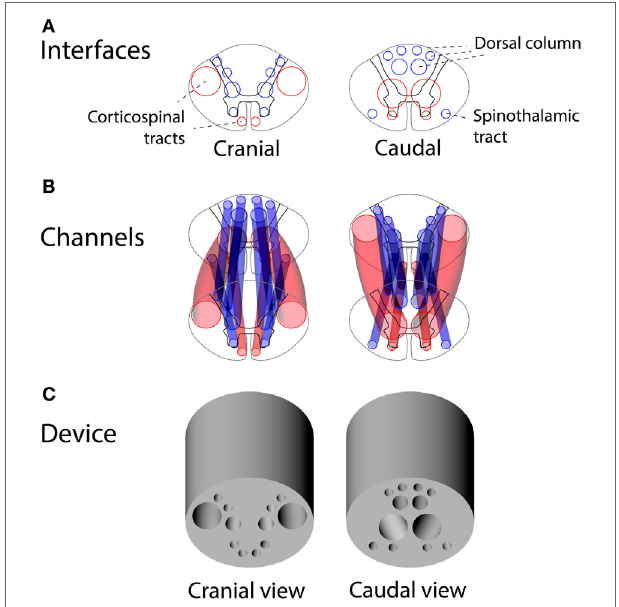
FigUre 5 | Design of the guiding device for precision grafting of peripheral nerves in thoracic spinal cord injury: (a) cranial and caudal interfaces based on human spinal tracts and white-to-gray matter rerouting of axons, (B) a 3D overview of guiding channels satisfying constraints of non-intersecting channels and minimal wall thickness of 0.4 mm, and (c) a 3D rendering of the guiding device.